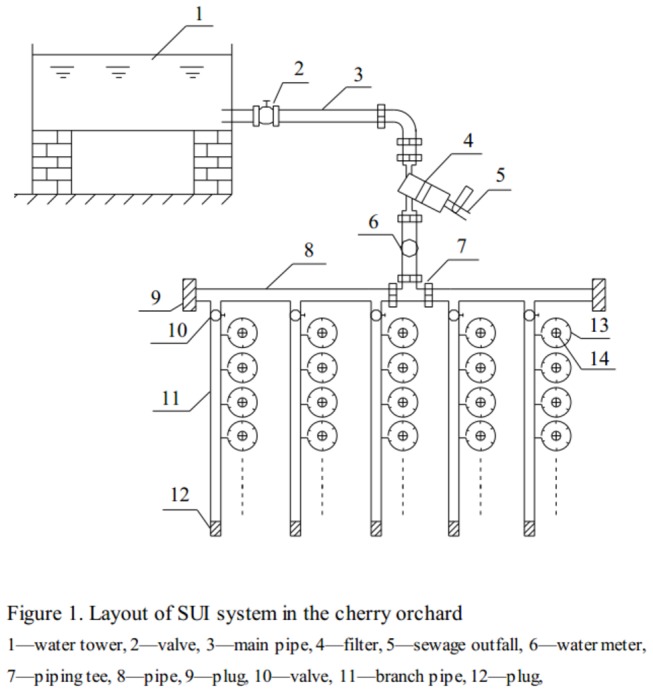
Layout of SUI system in the cherry orchard.